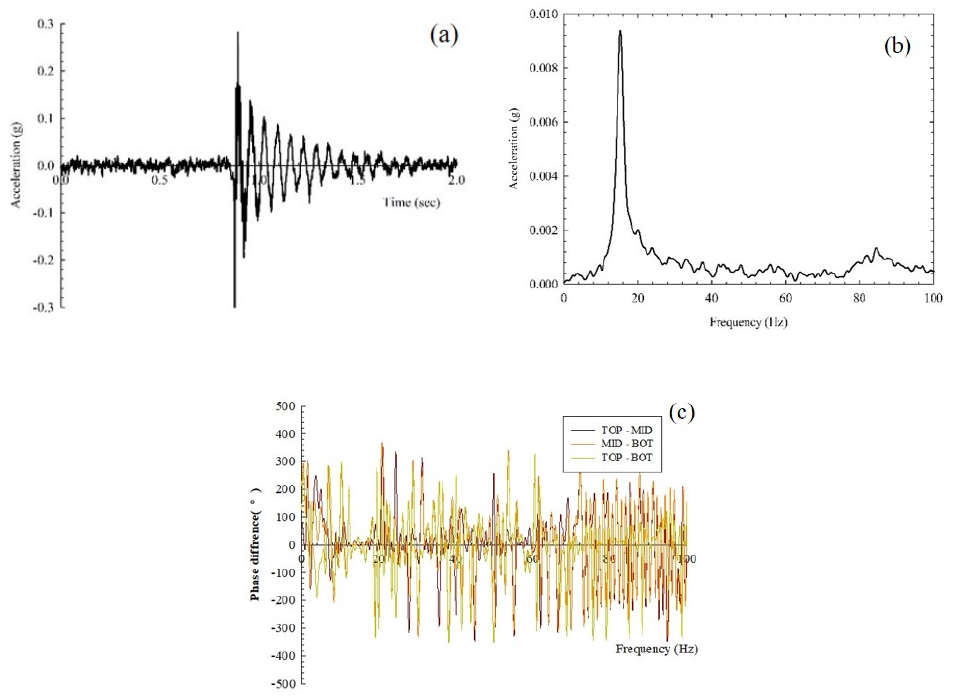
Figure 8. Natural frequency analysis method. ( a ) Representative signal; ( b ) representative natural frequency; and ( c ) representative phase.